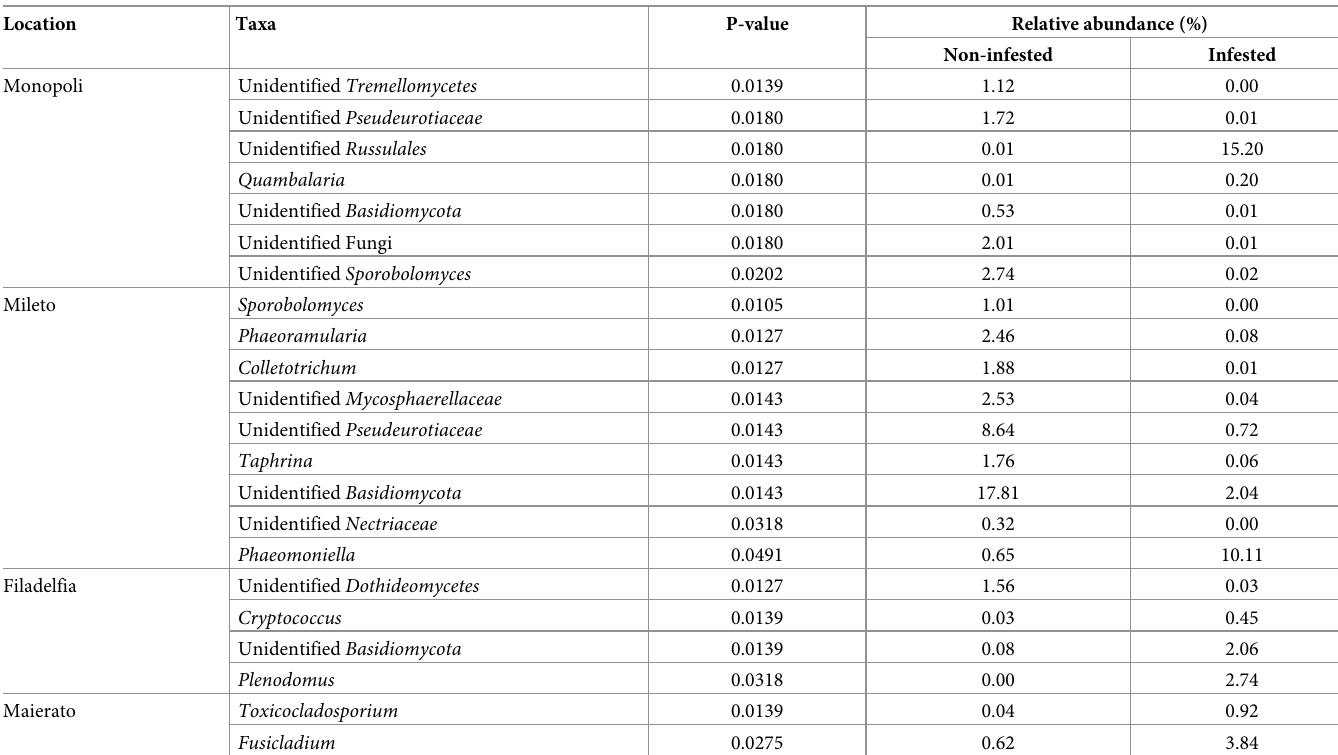
Table 5. List of taxa with a significant different relative abundance (RA) in infected and non-infected olive drupes, in the four investigated locations.